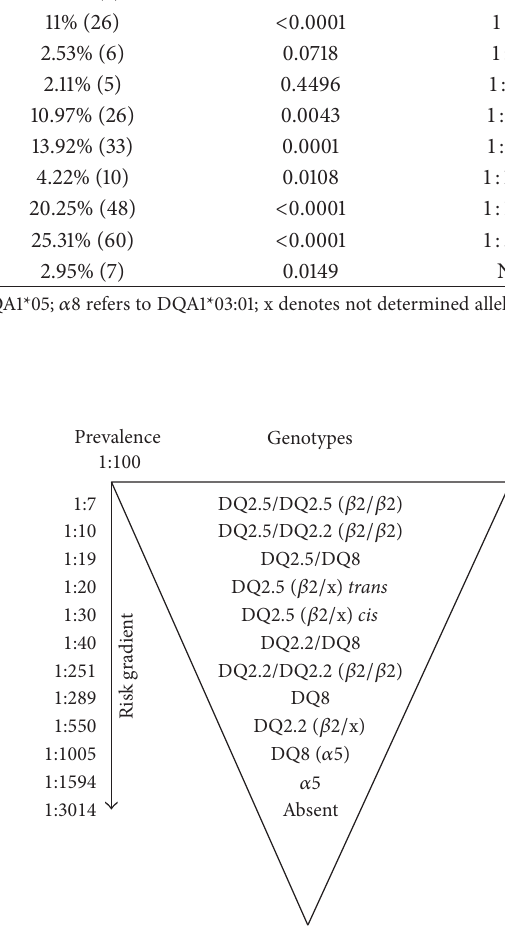
Figure 1: Risk gradient according to HLA haplotype combinations, considering a disease prevalence of 1:100. 𝛽 2 refers to DQB1*02; 𝛼 5 referstoDQA1*05;“x”denotescorrespondingallelenotdetermined; individuals with only one copy of the DQB1*02 allele were classified as 𝛽 2/x (heterozygosis); individuals with two copies of the DQB1*02 allele were classified as 𝛽 2/ 𝛽 2 (homozygosis); trans and cis indicate, respectively, 𝛼 5 and 𝛽 2 position in different or in the same chromo- some 6